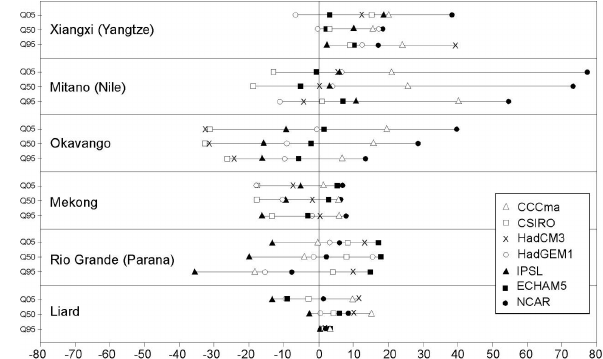
Figure 3. Envelope of projected 30-year mean changes in metrics of river flow (% 870 difference from 1961-1990 baseline) under a 2°C rise in global mean air temperature 871 Fig. 3. Envelope of projected 30-yr mean changes in metrics of river projected by 7 “priority” GCMs for the study basins. For each catchment, the top, 872 flow (% difference from 1961–1990 baseline) for the study basins. middle and bottom lines represents Q05, Q50 and Q95 flows (i.e. exceedance in % of 873 months over the simulated 30-year period). 874 For each catchment, the top, middle and bottom lines represents 875 Q05, Q50 and Q95 flows (i.e. exceedance in % of months over the simulated 30-yr